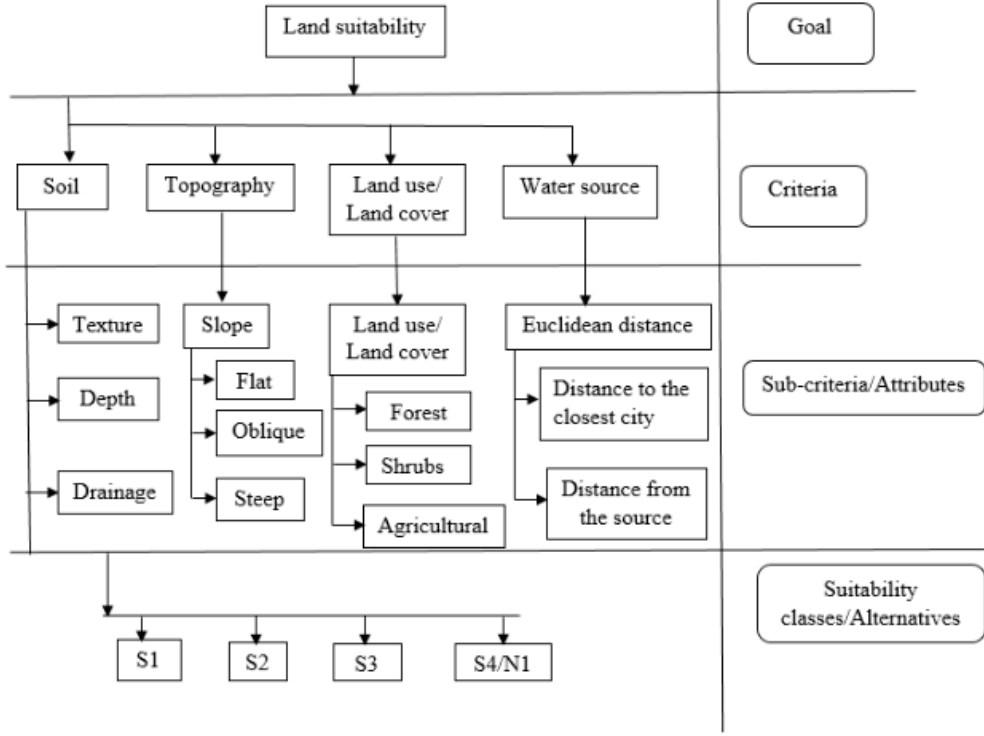
Figure 4. Flow diagram method of land suitability and irrigation potential mapping.